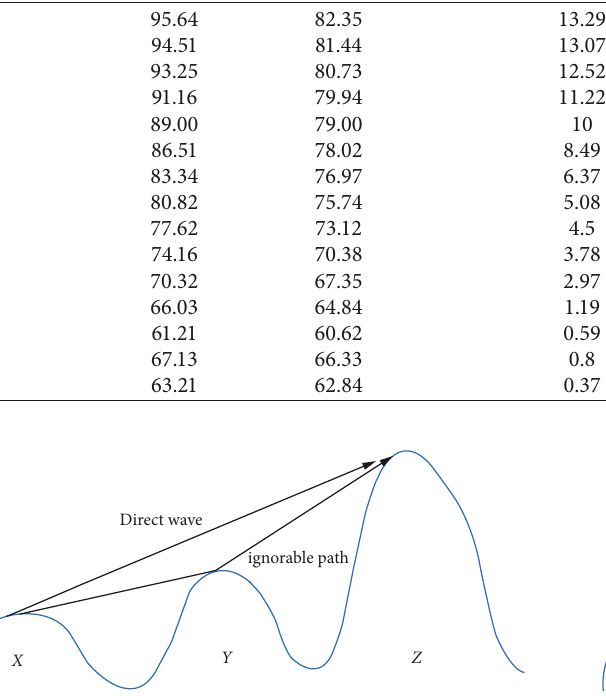
Figure 11: Invalid ocean waves in the link-peak diffraction model. Figure 12: Schematic diagram of propagation on two circular peaks in the link-peak diffraction